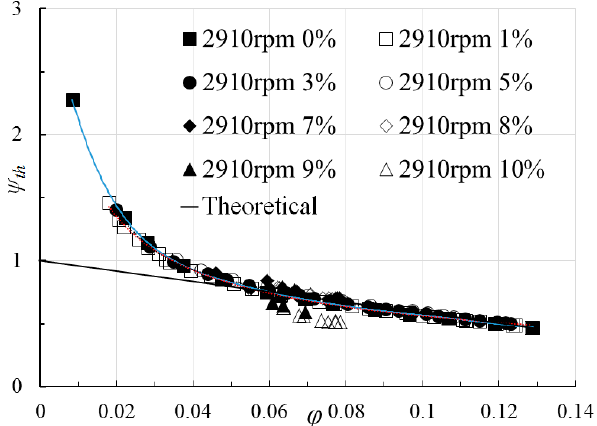
Figure 9. Theoretical head coefficient for nominal rotational speed (extracted from Si et al. [24]).